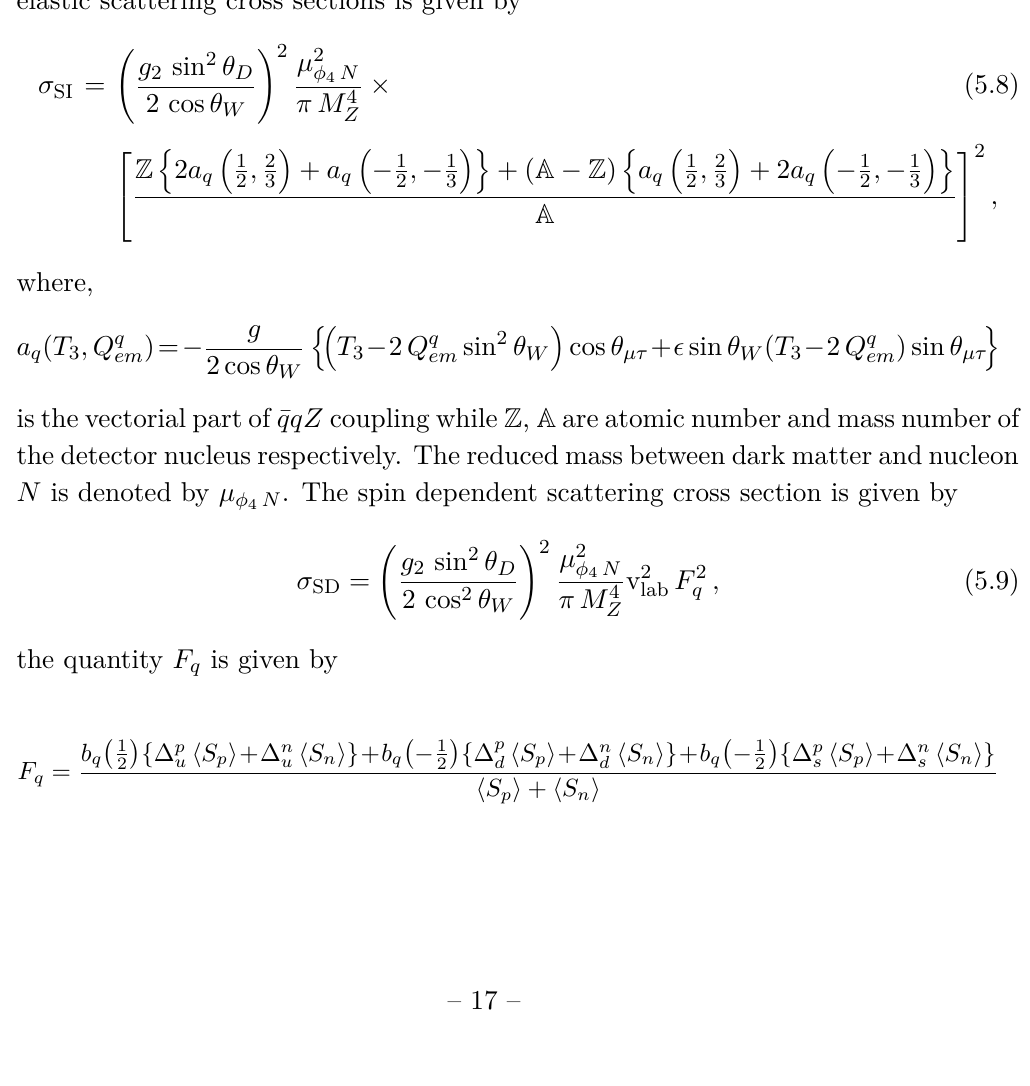
Figure 4 . Feynman diagrams for the self interactions between φ 4 φ 4 and φ 4 φ † the process φ †